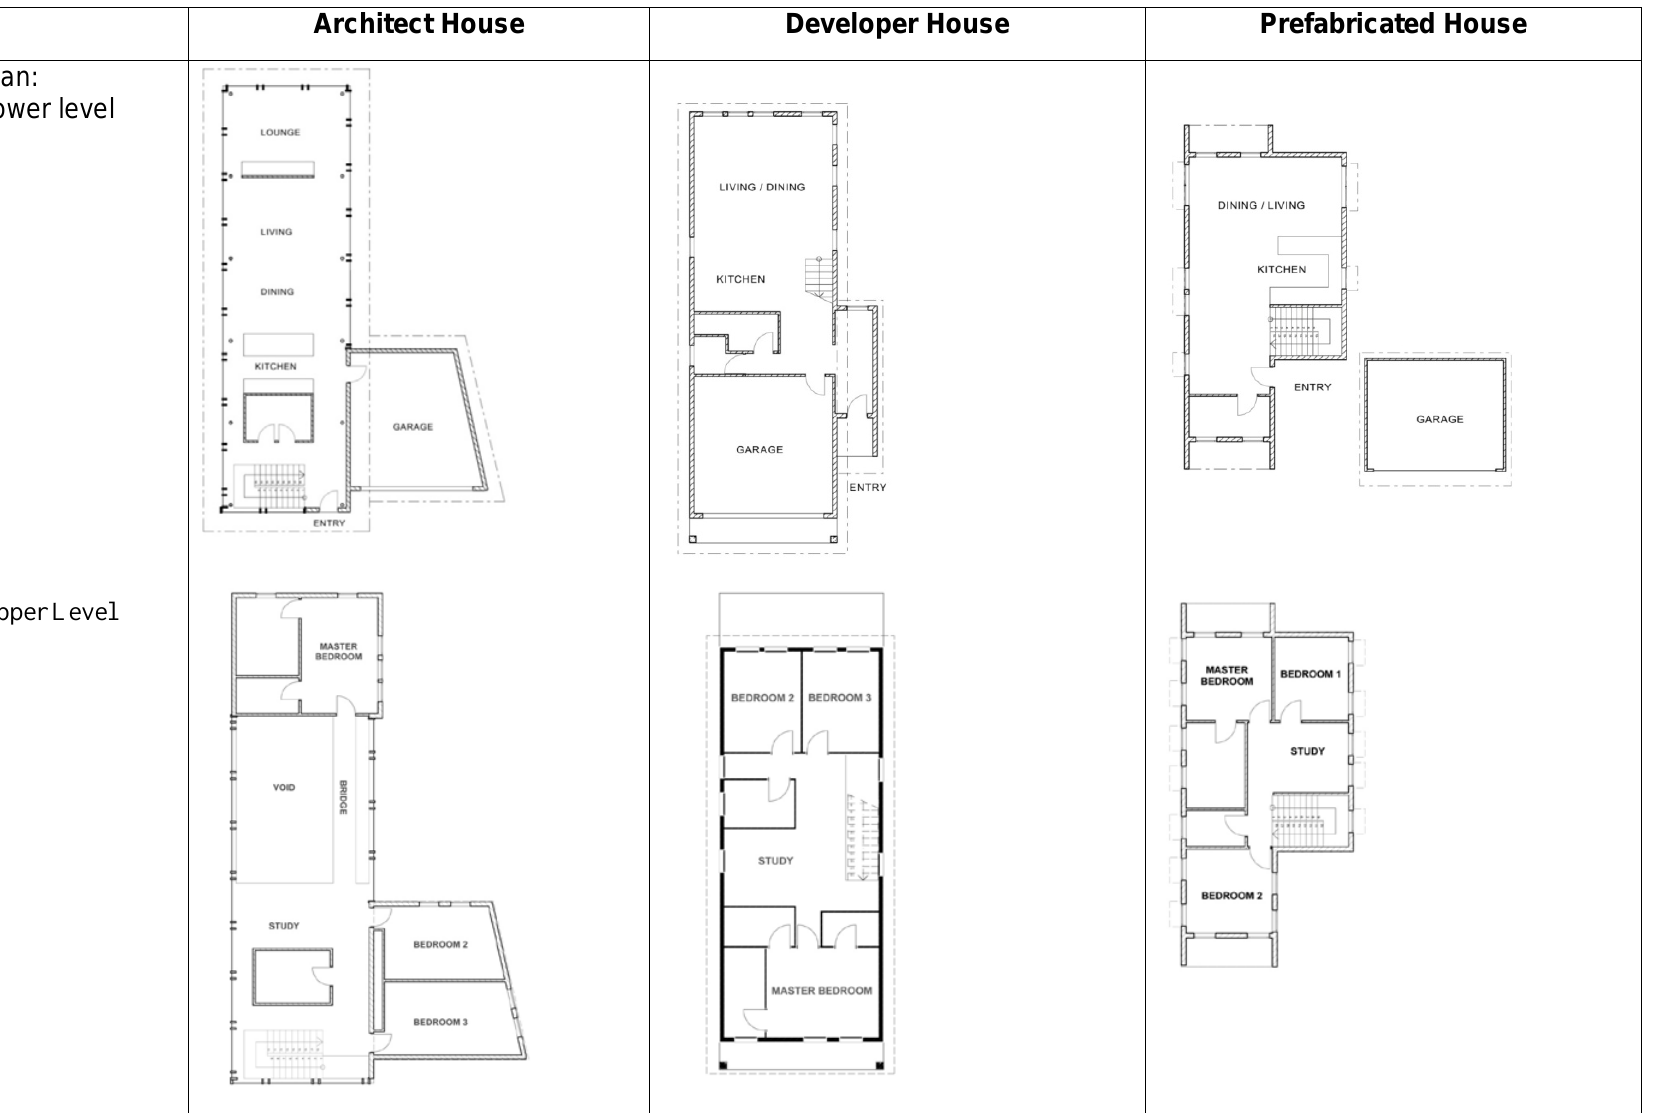
Table 2: Comparative information of three house